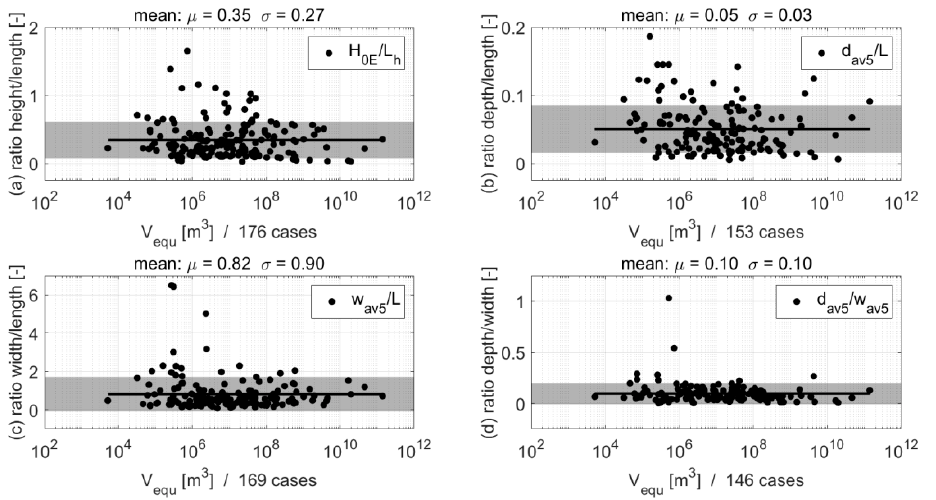
Figure 8. Examples of volume-to-ratio correlations for the set “full”. For shape-related parameters (i.e., here the ratios; H 0E / L h ( a ), d av5 / L ( b ), w av5 / L ( c ), and d av5 / w av5 ( d )), the mean values ( µ ) are calculated. The shadings indicate the symmetric belts of two standard deviations ( ± 1 σ ) around the mean values (µ). Table 5. Results for volume-to-ratio correlations for the set “full”. For all shape-related parameters (i.e., here the ratios), the mean values (µ) with the respective standard deviations ( σ ) and the sample sizes per sigma interval are given.